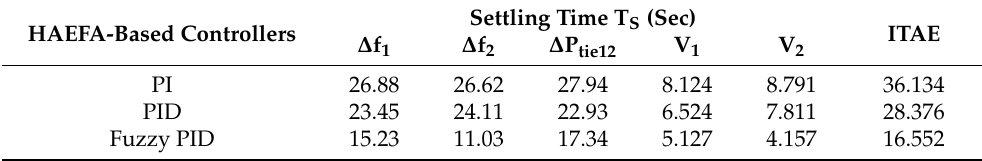
Table 3. Settling time of responses in case-1.